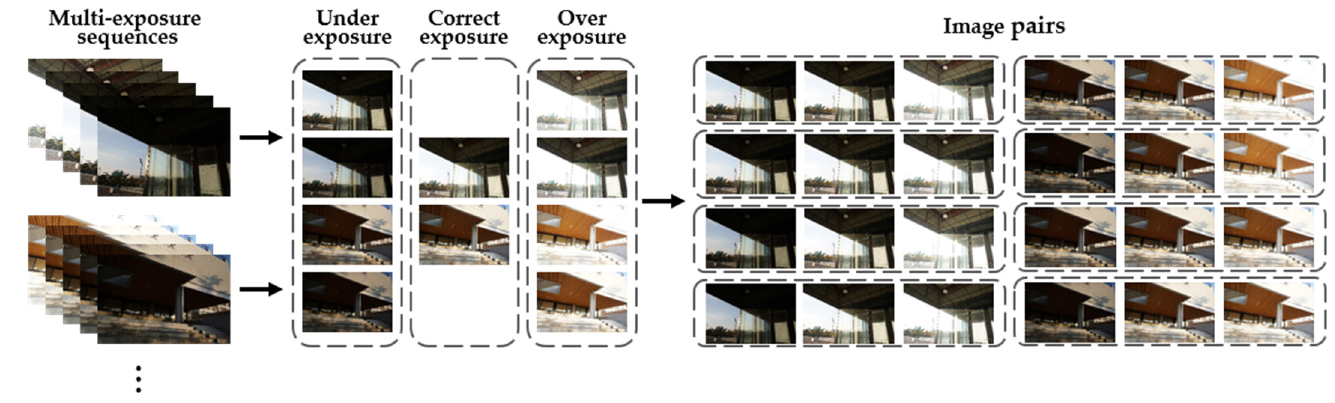
Figure 4. Training image pairs acquisition from multi-exposure datasets.